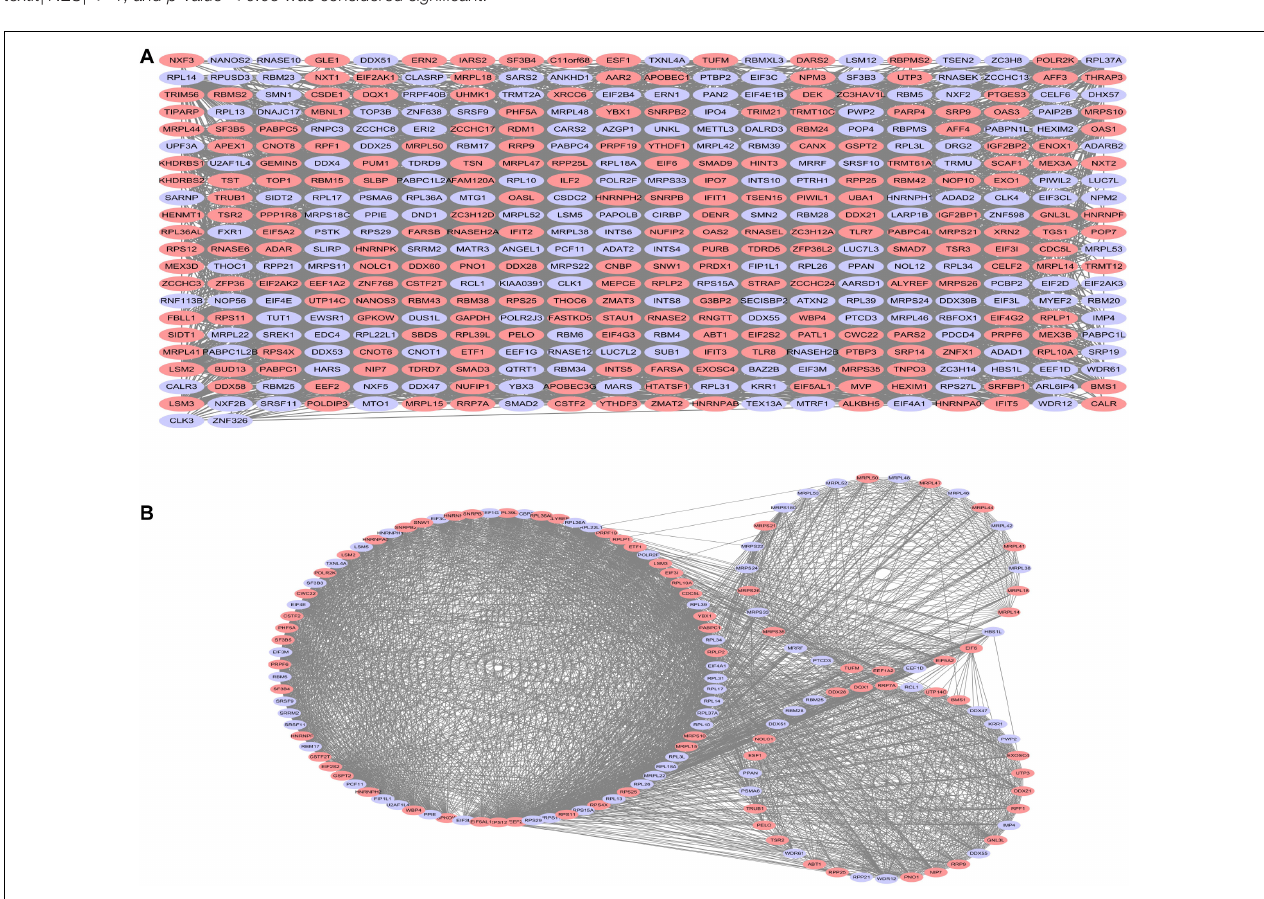
FIGURE 4 | Protein–protein interaction (PPI) network analysis (A) and critical sub-network analysis (B) . Lilac ovals, downregulated RBPs; pink ovals, upregulated RBPs.